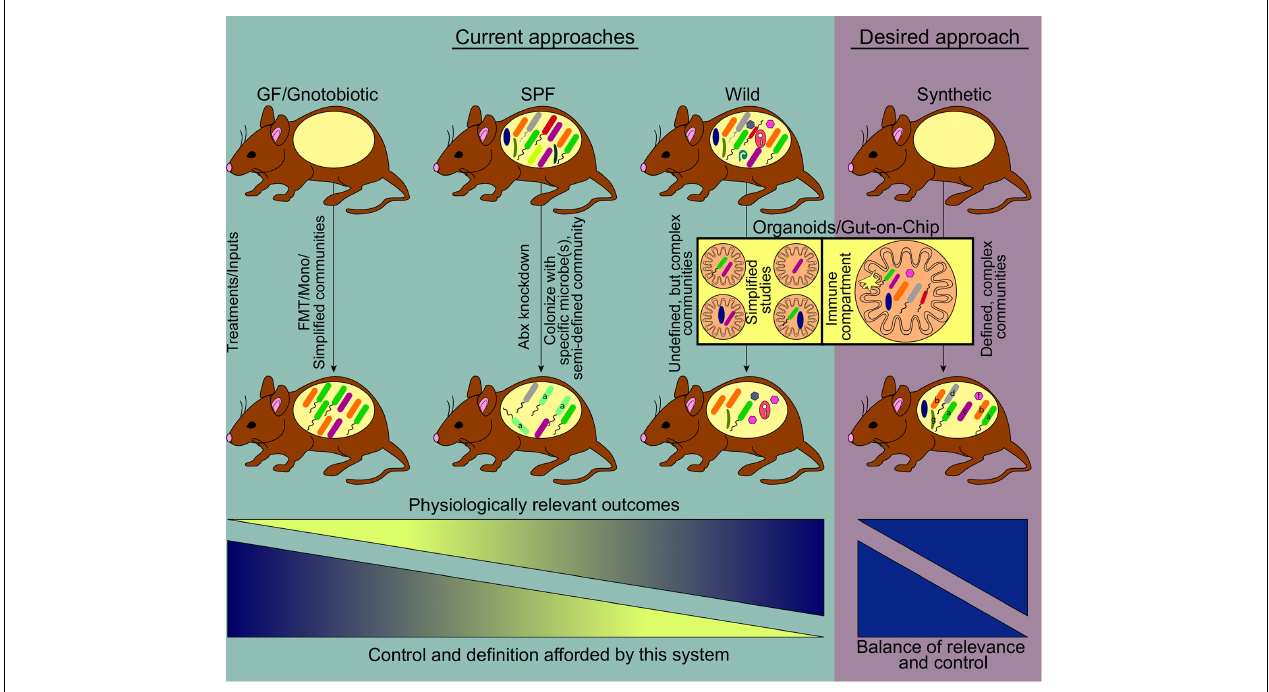
FIGURE 1 | Current and emerging systems to study host-gut microbiome interactions. Prevalent model systems in use to study physiological effects of gut microbiome-host interactions and representative community complexity within each model are shown (teal shaded area). The general usefulness of these systems based on physiologically relevant outcomes, increases left to right. At the same time, the ability to manipulate or define the community structure of these models decreases along the gradient, driving the need for a medium where physiologic relevance and tractability reach an optimum. Current technologies striving toward this desired model include the use of germ free mice where synthetic communities of known microorganisms are used for colonization, as well as the use of emerging lab-on-chip approaches (pink shaded area) (FMT, fecal microbiome transplant; Mono, monocolonization; Abx,